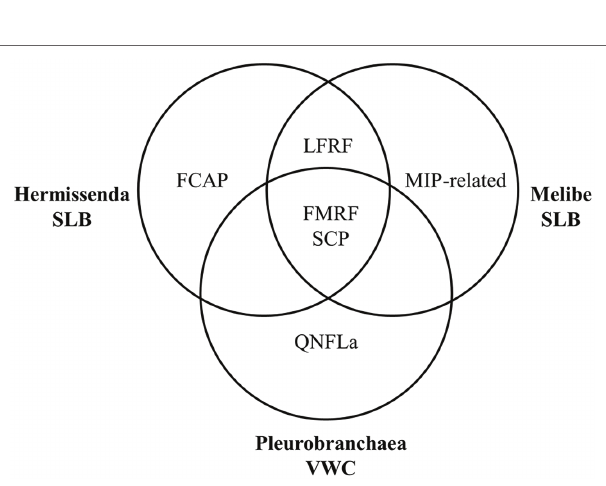
FIGURE 5 | Summary of the prohormone families present in each species’ neuron. Each species has peptides from the FMRFa and SCP prohormone families, both nudibranchs have peptides from the LFRFa prohormone family, and each species has a prohormone family not detected in the other species’